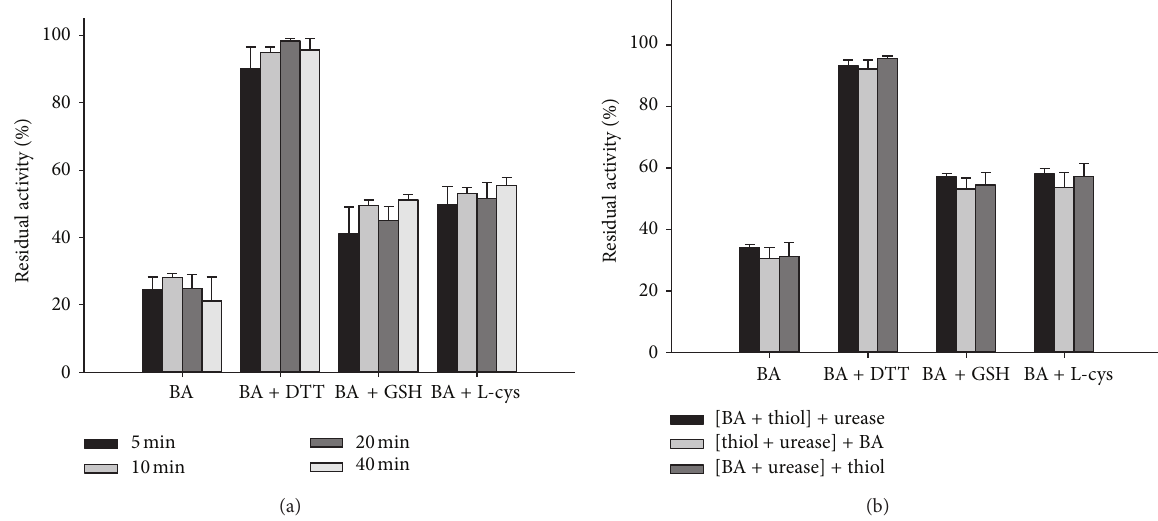
Figure 6: (a) Thiol influence on urease inactivation by BA relative to the control activity. The percent of the enzyme activity in the presence of BA without the thiol is given as comparison. Concentration of the thiol: L-cys, GSH, DTT, and BA were 3.75 mM. Enzyme activity was determined after 5, 10, 20, and 40min of incubation. (b) Influence of thiol order of components preincubation on urease inactivation by BA. The initial 20 min preincubation mixture contained components given in brackets. The preincubation was continued the further 20min after addition of the last component (component given outside for brackets). The final preincubation mixtures contained 0.25 mg/mL urease, 20 mM phosphate buffer, pH 7.0, 2 mM EDTA, 3.75 mM BA, and DTT, GSH, or L-cys. Enzyme activity was determined after 40 (20 + 20) min of preincubation time. The percent of the enzyme activity in the presence of BA without the thiol is given for comparison. The results are expressed as means ± SD of the data from triplicate